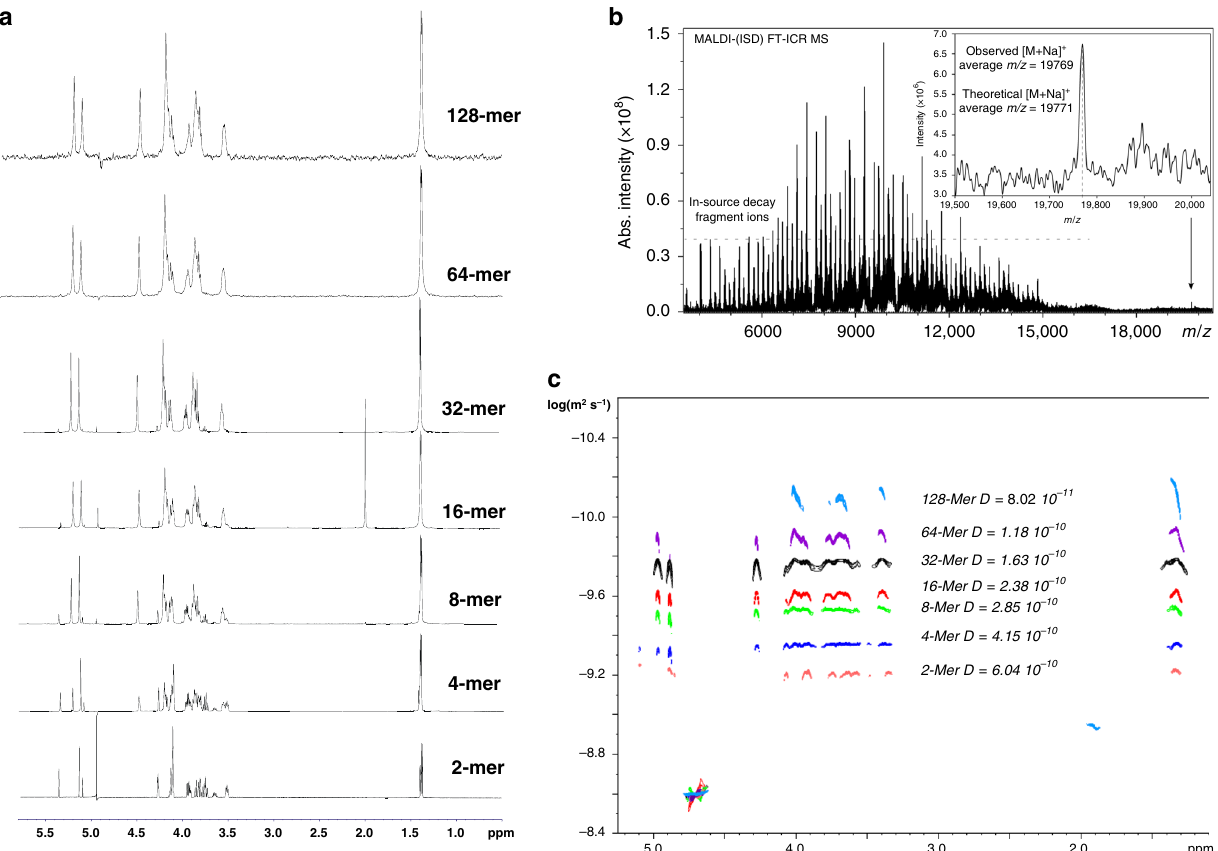
Fig. 3 Characterization of the glycans. ∣ a Overlaid 1 H-NMR spectra (acquired on Bruker 600 MHz with cryogenic probe and analyzed with Bruker Topspin) of the free glycans 1 – 7. b MALDI-FT-ICR-MS spectrum of 128-mer 7 . The observed average m/z of 128-mer 7 , detected as [M + Na] + , is in agreement with the calculated theoretical value ( m/z 19771.1). c 2D diffusion ordered spectroscopy (DOSY) NMR spectra of glycans 1 – 7. The x -axis represents the 1 H-NMR dimension; the y -axis represents the diffusion dimension; the double-logarithmic plot of D against Mw (Supplementary Fig. 13) provided a calibration curve described by the least-squares fi tted linear equation Log D = − 7873 − (0.486*Log Mw). Source data are provided as a Source Data fi